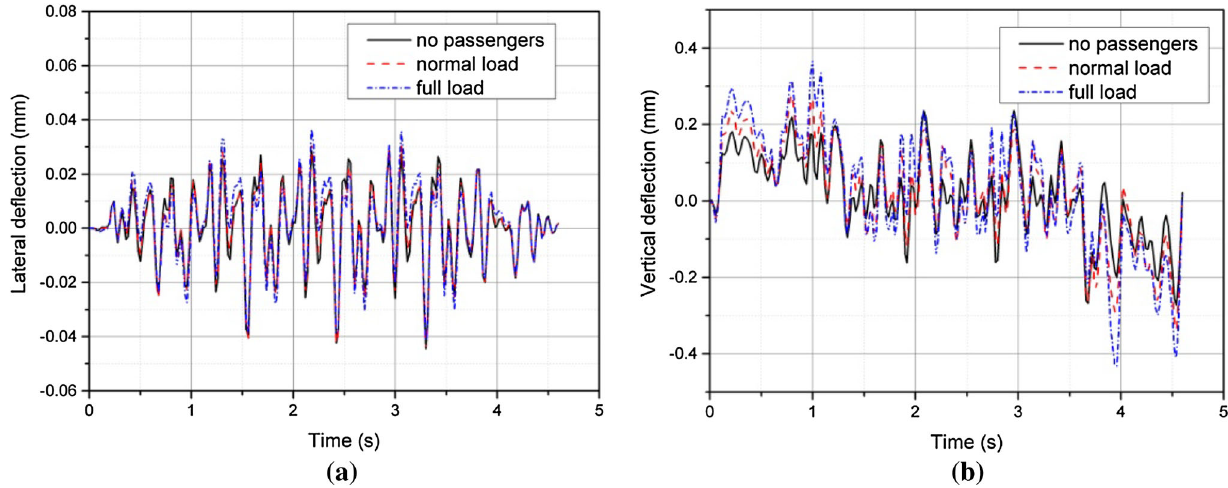
Fig. 12 Record of vibration amplitude at middle span (unit: mm). a Lateral, b vertical